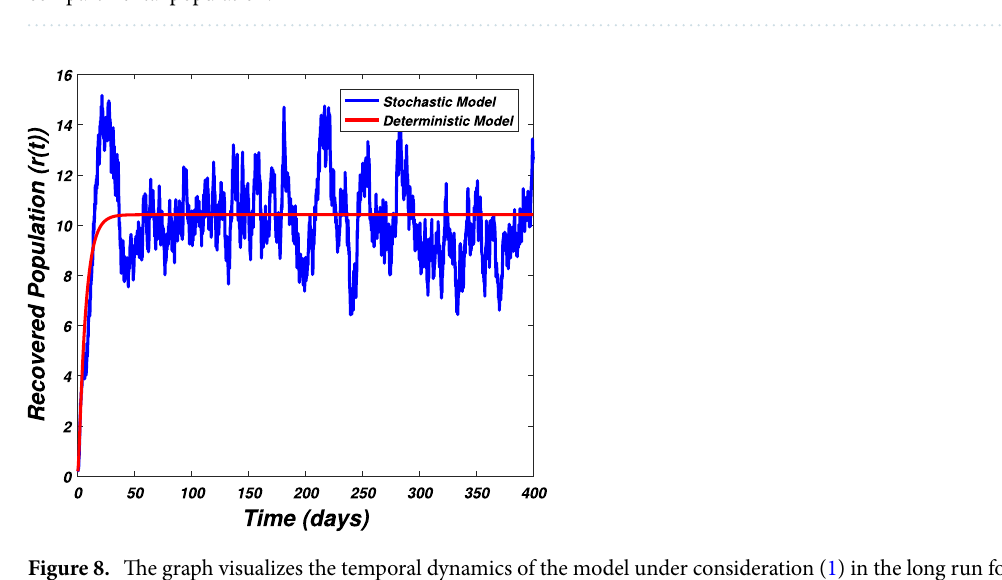
Figure 7. The graph visualizes the time dynamics of the model (1) in case of extinction for the class of infected population ( i ( t )) against parametric values taken from S 1 and (0.5, 0.3, 0.2, 0.1) are the initial sizes for compartmental population.